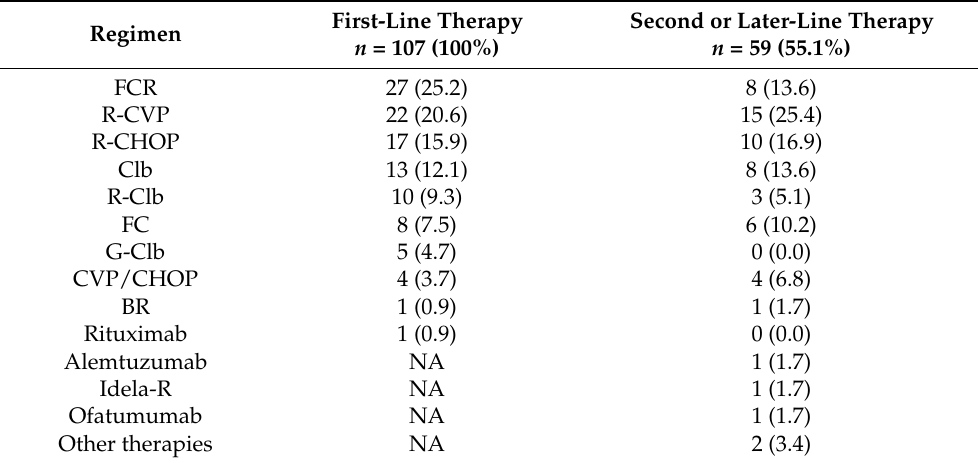
Table 2. Prior therapy for CLL.